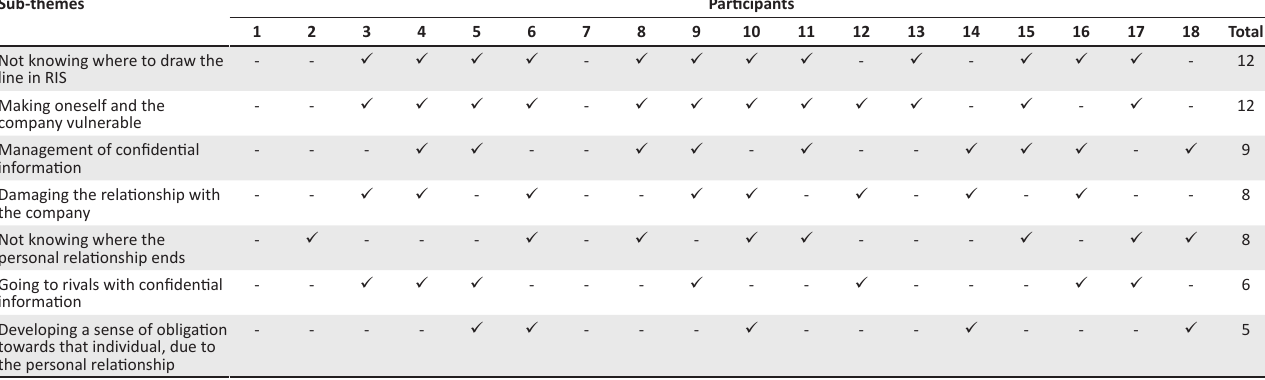
TABLE 4: Frequency of challenges associated with risk information sharing. Sub-themes